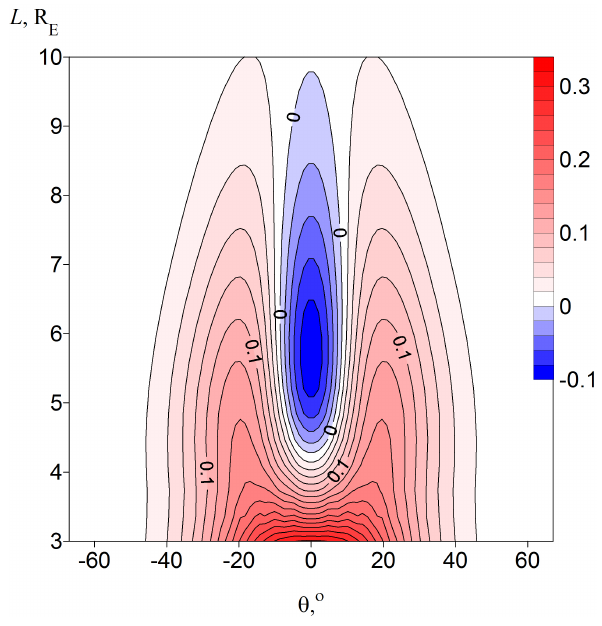
Fig. 5. The radial profiles of Alfv´en speed A(L) , β(L) and trans- verse current j ⊥ (L) in the equatorial plane. Here L = r/R E is the magnetic shell parameter.